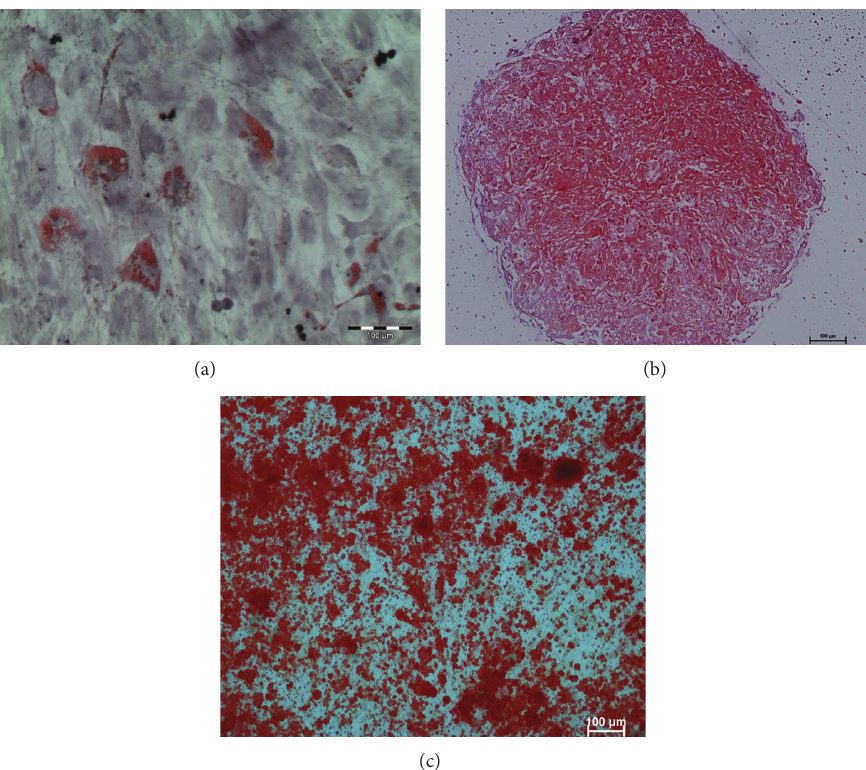
Figure 3: The functional assays for differentiation of culture MSCs. (a) Representative images of adipogenic differentiation demonstrated by formation of oil droplet. (b) Chondrogenic differentiation demonstrated by positive expression of proteoglycans matrix within the pellet stained with Safranin O/fast green staining. (c) Osteogenic differentiation demonstrated by positive bone matrix mineralization stained with Alizarin Red S staining.